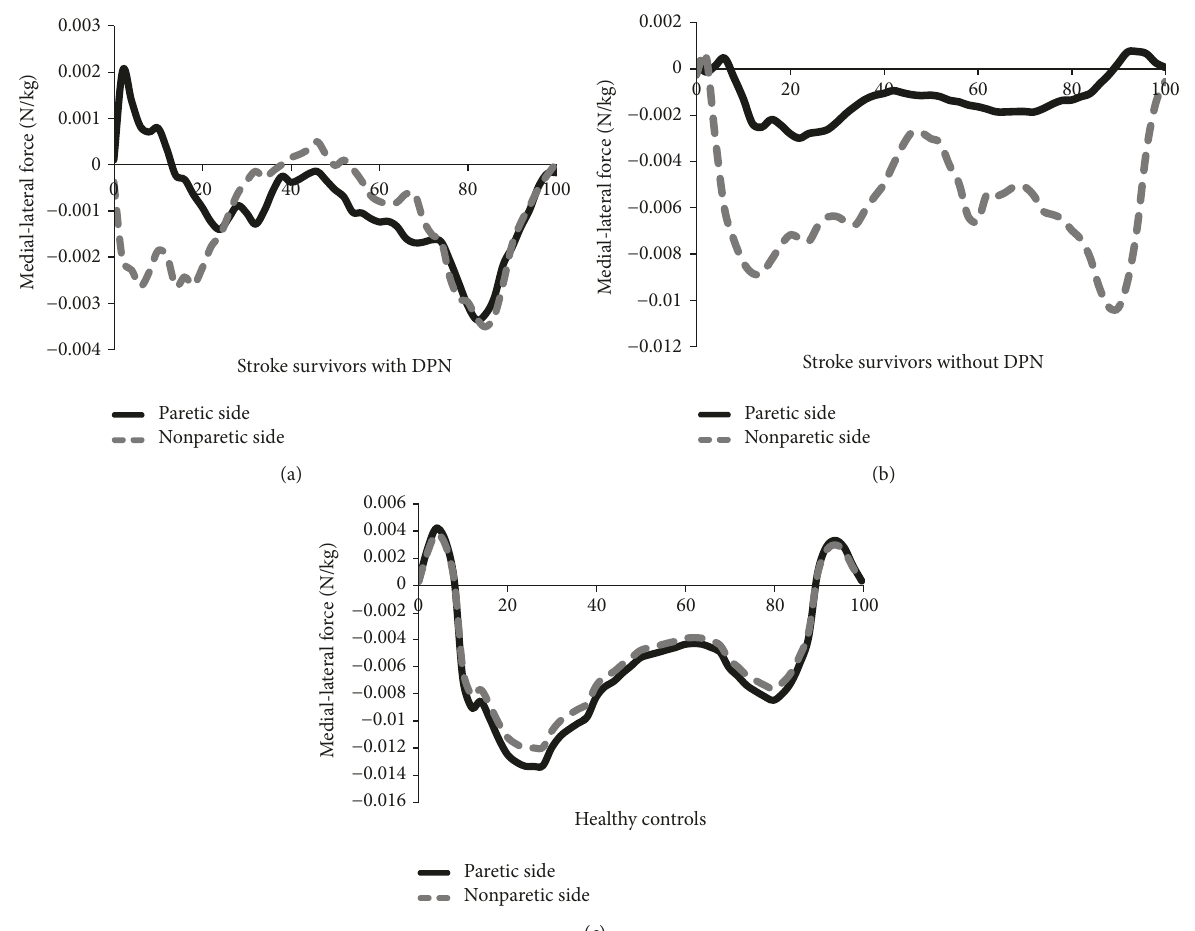
Figure 2: (a) Medial-lateral forces of the paretic and nonparetic side of stroke survivors with DPN. (b) Medial-lateral forces of the paretic and nonparetic side of stroke survivors without DPN. (c) Medial-lateral forces of the paretic and nonparetic side of healthy controls. DPN: diabetic peripheral